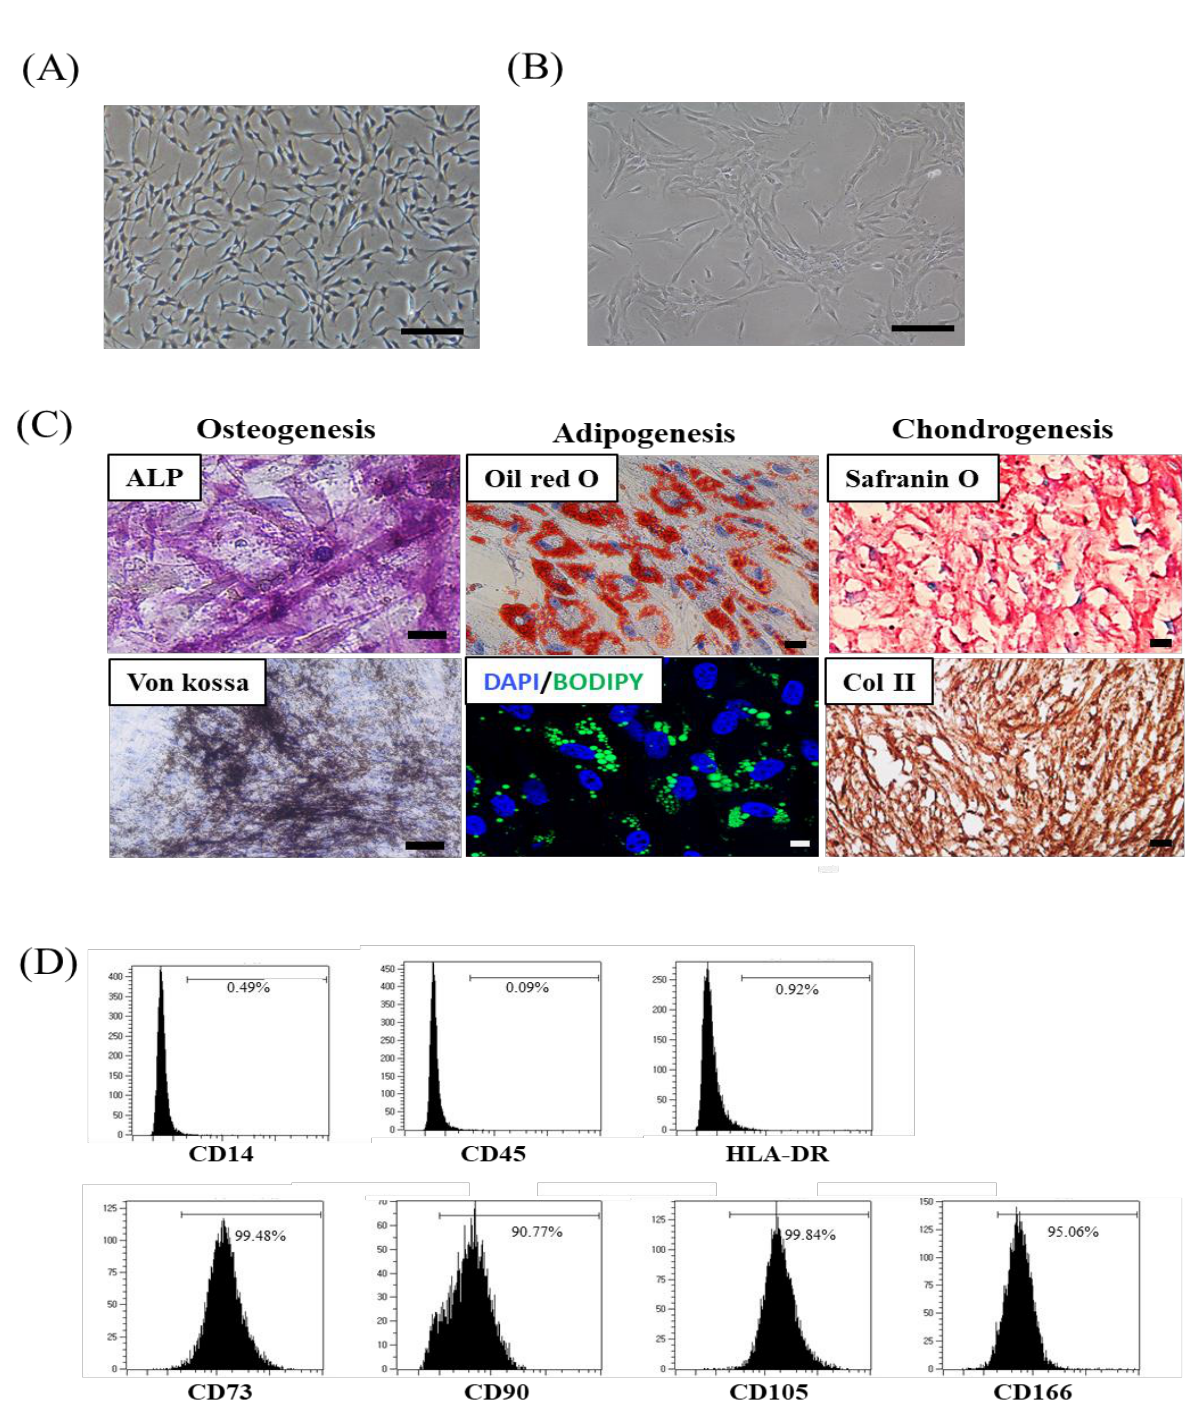
Figure 2. SMUP-Cell characterization. ( A ) Morphology shows adherent spindle-shaped cells at passage 6. ( B ) Cell staining measured SA β -gal as a senescence phenotype; it revealed no positive cells. ( C ) During incubation in a specialized induction medium, multi-lineage potential was demonstrated by staining typical multi-lineage markers. Osteogenic cells were analyzed according to ALP and von kossa levels. Adipogenic cells showed increased lipid vacuoles within the cytoplasm via Oil Red O and BODIPY (green) staining. Chondrogenic cells accumulated sulfated proteoglycans stained with Safranin O. Nuclei were counterstained with hematoxylin. Nuclei were stained with DAPI (blue). The merged image is an overlay of the DAPI and BIODIPY images. Scale bar = 100 µ m. ( D ) Flow cytometric analysis of cells based on the cell-surface expression of typical MSC markers. Cells were strongly positive for the MSC markers CD73, CD90, CD105, and CD166 and negative for CD14, CD45, and